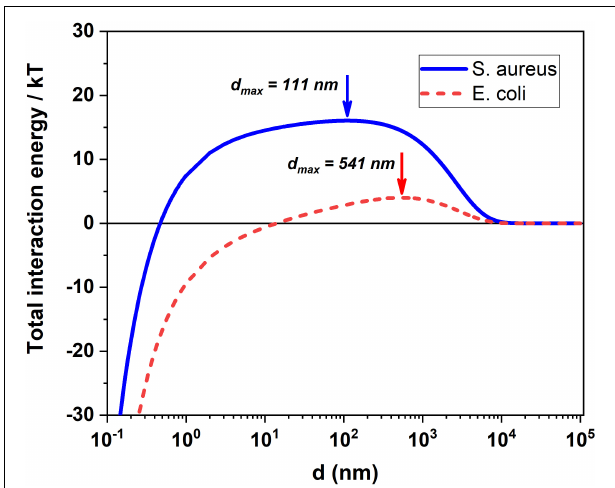
FIGURE 3 | DLVO prediction for the total interaction energy between MoS 2 NSs and S. aureus / E. coli in our experimental condition. Total interaction energy between the bacteria and MoS 2 NSs and d (nm) indicates the location of energy maxima for both E. coli and S. aureus at 541 nm and 111